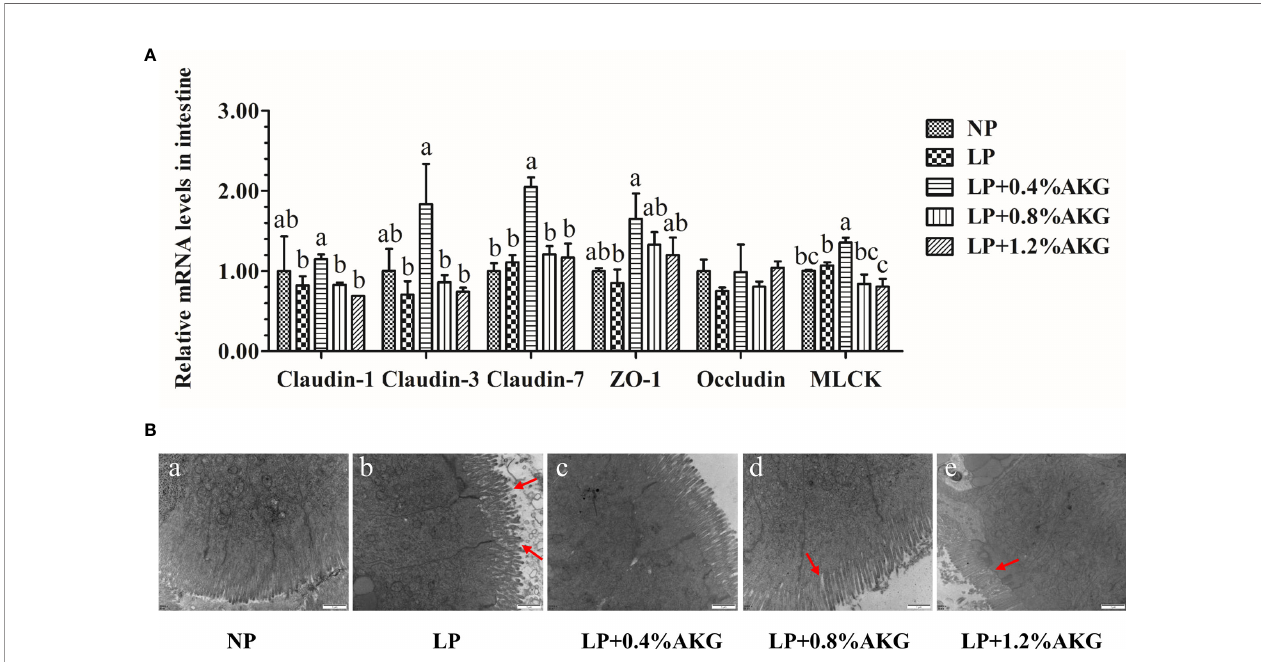
FIGURE 4 | Tight junctions in the intestine of common carp ( Cyprinus carpio ) fed with diets containing normal protein (NP), low protein (LP), and different concentrations of alpha-ketoglutarate (AKG) after 8 weeks. (A) Relative expressions of tight junction-related genes via MLCK signaling pathway. Tight junction-related genes includes claudin-1, claudin-3, claudin-7, zonula occludens-1 (ZO-1), occludin and myosin light chain kinases (MLCK). Values are expressed as the mean ± SEM (n = 4). Values marked with different letters indicate signi fi cant differences ( P < 0.05) between groups. (B) TEM micrographs. Scale bar of TEM is 1 m m.